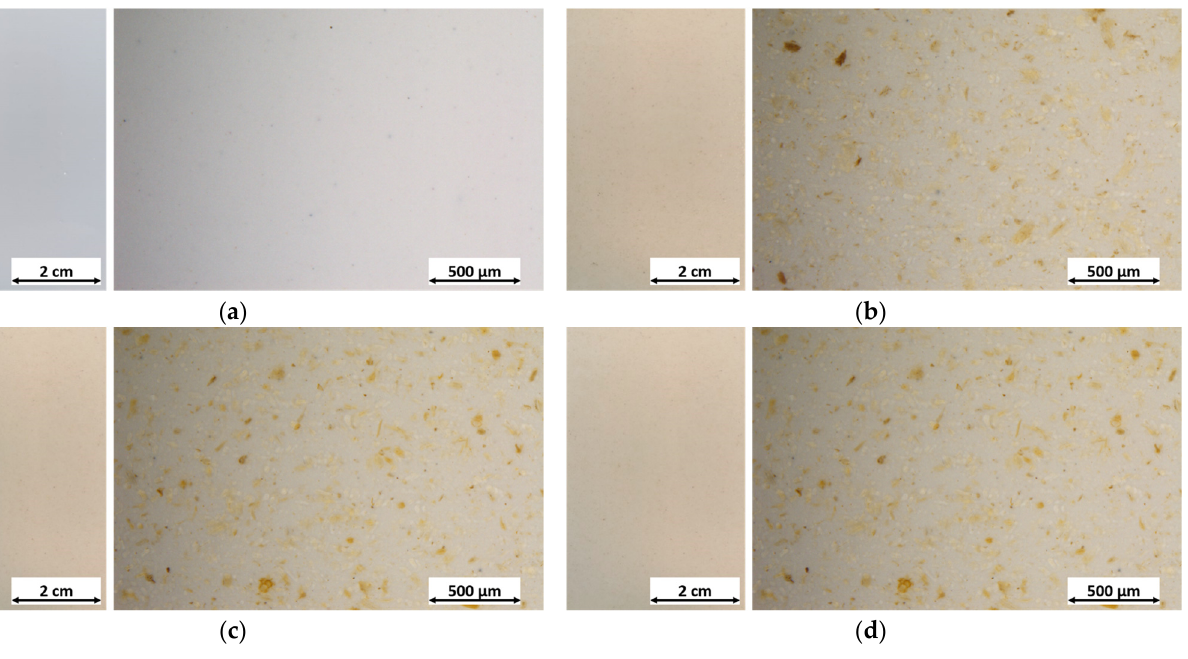
green, and zero as neutral parameter), and the yellow-blue coordinate (yellow for positive values, blue for negative values, and zero as neutral parameter),